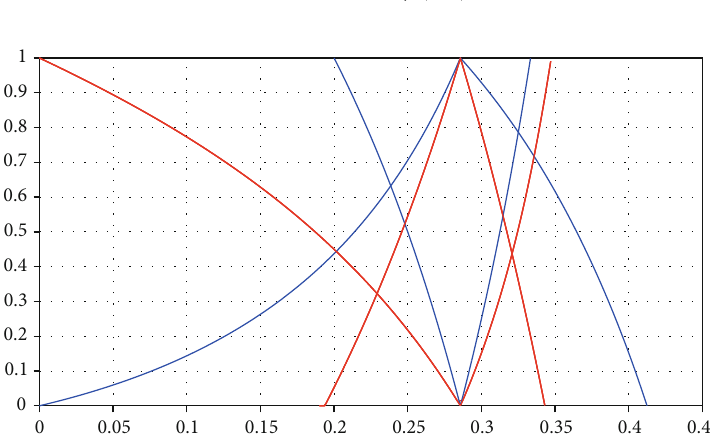
Figure 7: Solution by h u , v i -cut.